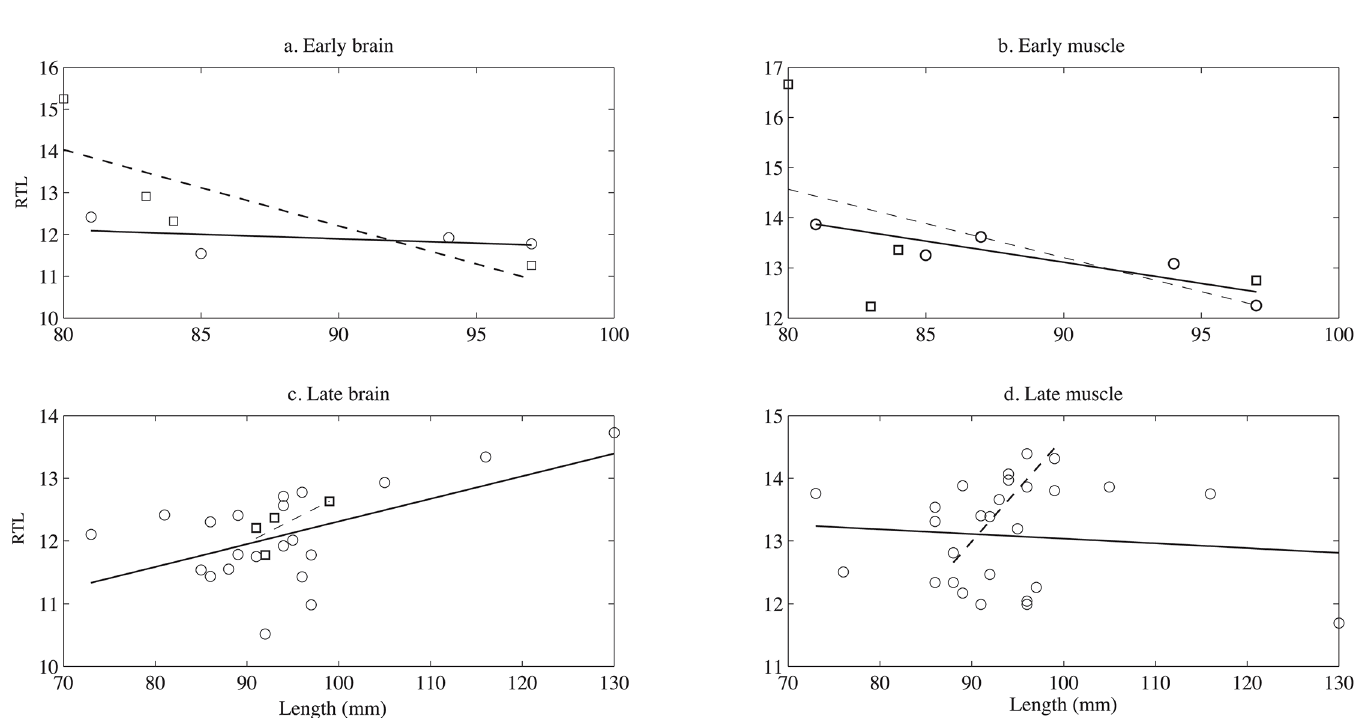
Fig 3. Relationship between RTL and growth history (final length). The RTL from both brain and muscle tissue from fish at the early breeding period is shown in a and b. The RTL from both brain and muscle tissue from fish at the late breeding period is shown in c and d. The dashed lines and solid lines are fitted linear regressions for female samples and male samples respectively.